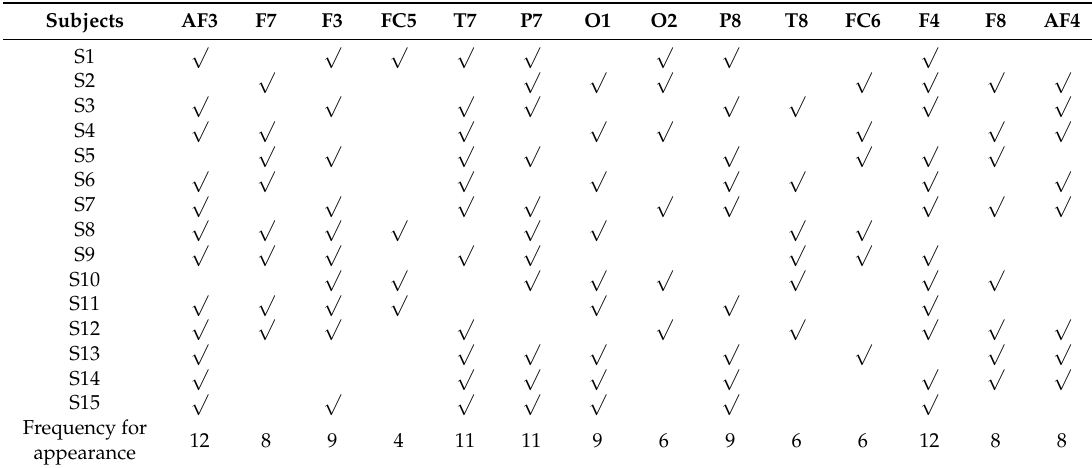
Table 4. Frequency of channels appearance for each subject based on spatial filter